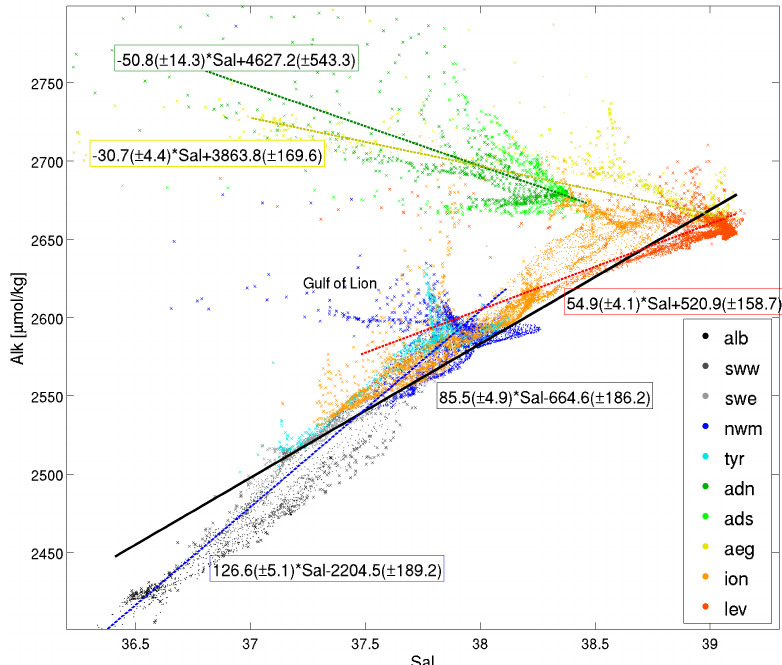
Figure 4. Regressions between salinity and alkalinity at the surface. Coloured points belong to the different sub-basins of Fig. 1. The regression for the whole Mediterranean Sea is shown as a black solid line, and the equation is reported in the black box (95% confidence intervals of the coefficients are in brackets; p <0.001; R 2 = 0.91; RMSE = 18.8). The regression uses data from the alb, sww, swe, tyr, ion and lev sub-basins with depths greater than 200m. Sub-basin regressions are computed for the Adriatic sea (green box and line; data from adn and ads; R 2 = 0.45, RMSE = 32.0), the Aegean Sea (yellow box and line, data from aeg; R 2 = 0.77, RMSE = 9.3), the western Mediterranean Sea (blue box and line; data from alb, sww, swe and tyr with depths greater than 200m; R 2 = 0.95, RMSE = 11.6) and the eastern Mediterranean Sea (red box and line; data from ion and lev with depths greater than 200m; R 2 = 0.74, RMSE = 13.8).